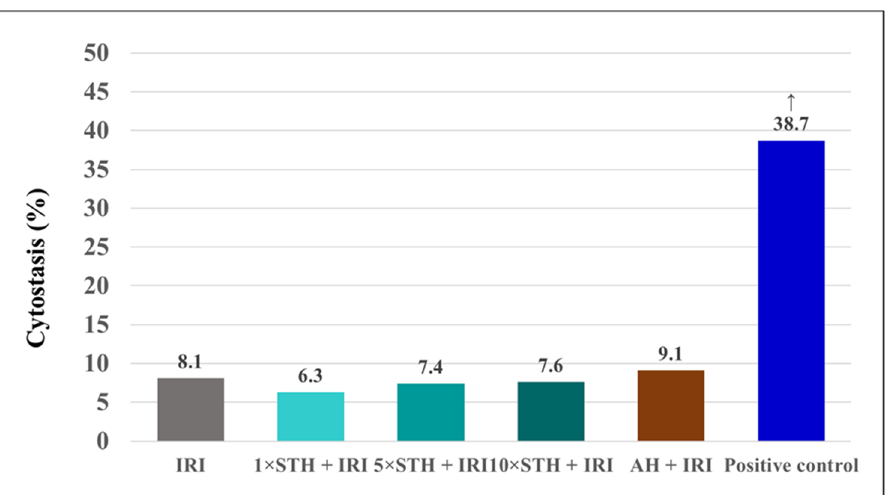
Figure 8. The extent of cytostasis produced in the cultures established after treatment with different combinations of the cytotoxic drug irinotecan (IRI) with strawberry tree honey (STH) and artificial honey (AH). Single-IRI-treated cells and positive control (bleomycin—15 mg/L) cells were studied in parallel. Significantly increased ( p < 0.05) value is ↑ —vs. all other experimental groups.